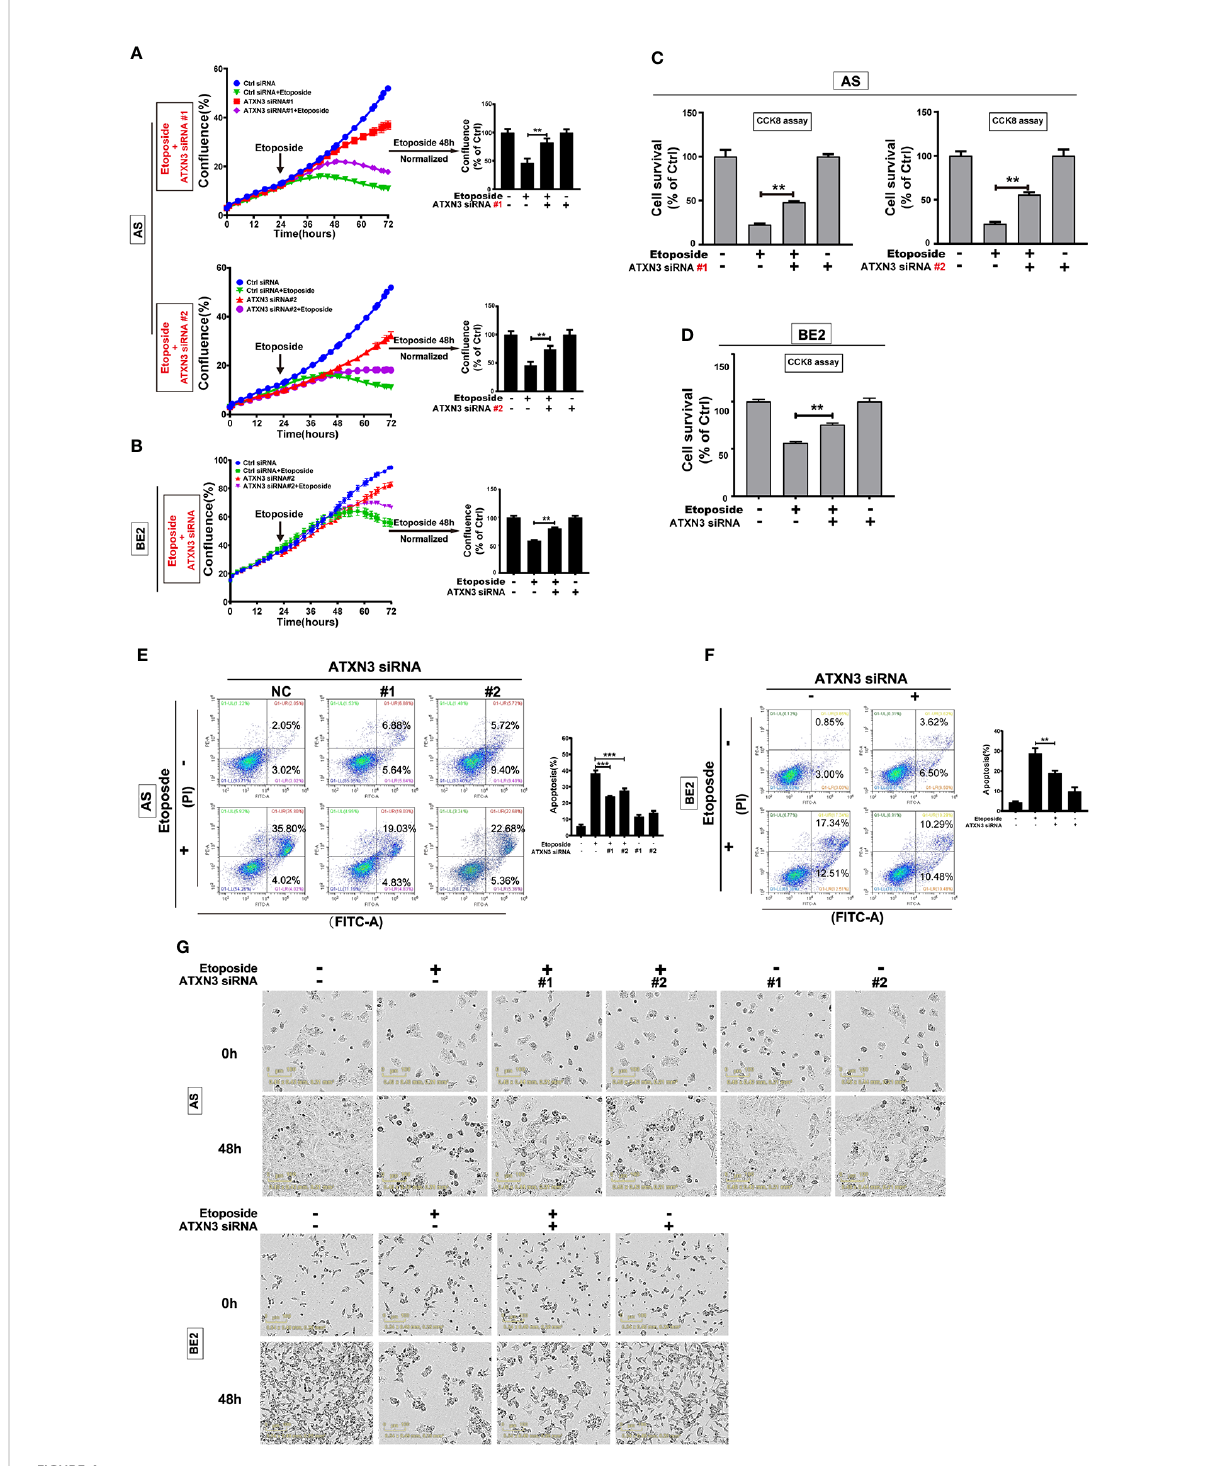
FIGURE 4 Downregulation of ATXN3 decreased the sensitivity of NB cells to etoposide. AS cells were transfected with ATXN3 siRNAs (#1, #2) and BE2 cells were transfected with ATXN3 siRNA #2 (marked as ATXN3 siRNA) for 16 h, followed by 48 h treatment of etoposide. (A, B) Cell con fl uence was dynamically detected and analyzed by IncuCyte Zoom; (C, D) Cell survival was detected by CCK8 assay; (E, F) Cell apoptosis was detected by Annexin V/PI fl ow cytometry; (G) The images of AS and BE2 cells with ATXN3 siRNAs transfection and etoposide treatment at 0 h and 48 h were recorded. Bar, SD, ***, P<0.001, **, P<0.01, ATXN3 siRNAs + etoposide vs. control siRNA +